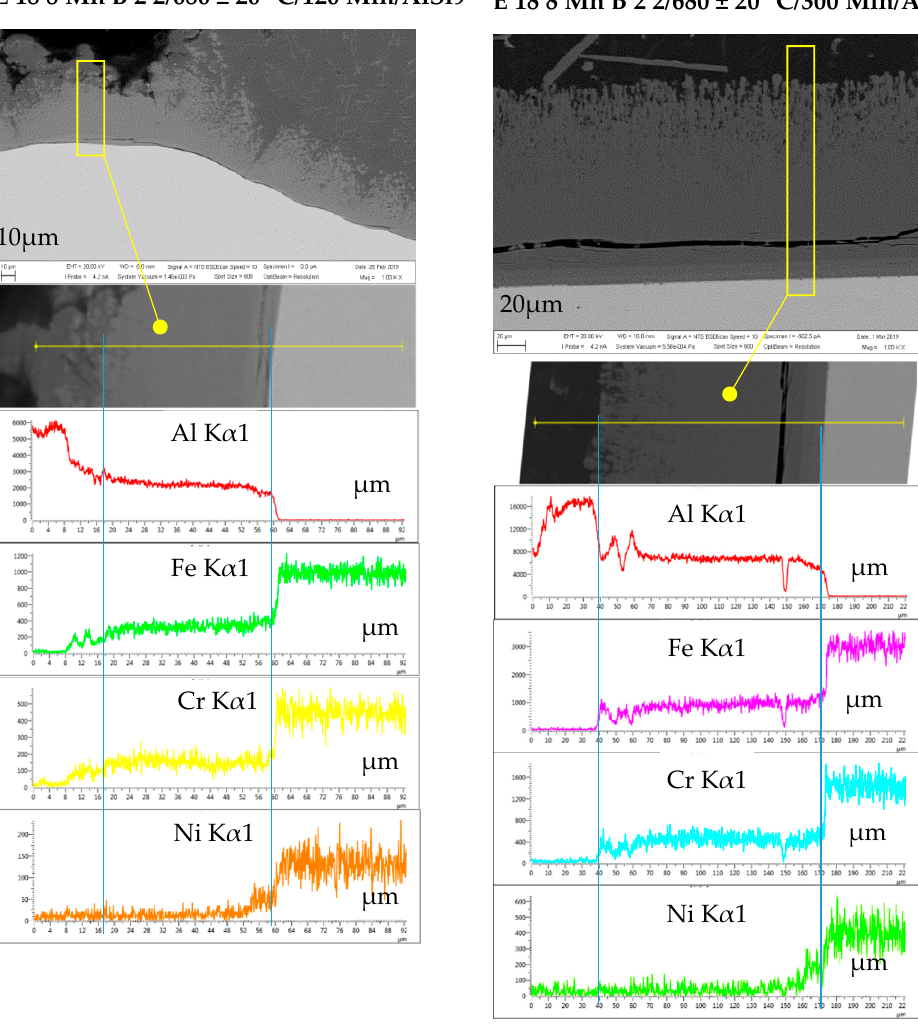
Figure 22. EDX line microanalysis.